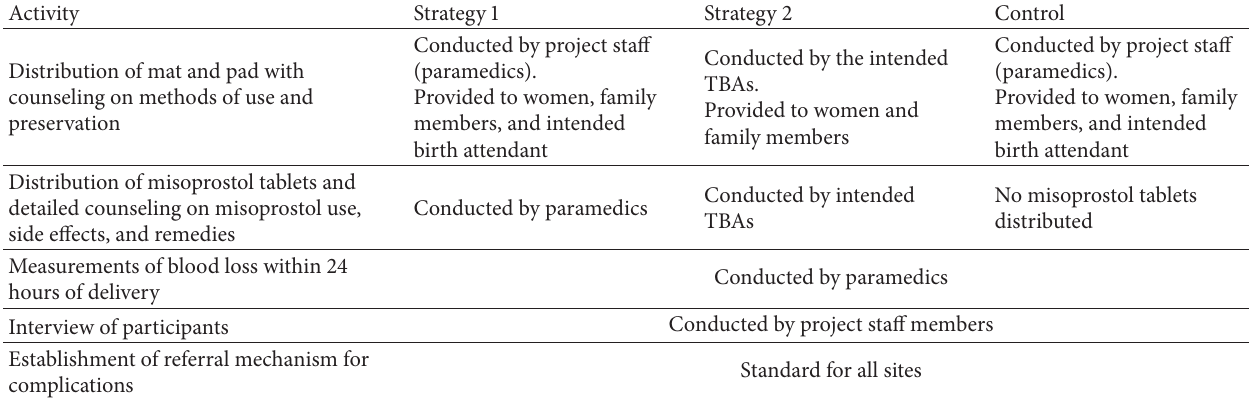
Table 1: Project activities by study